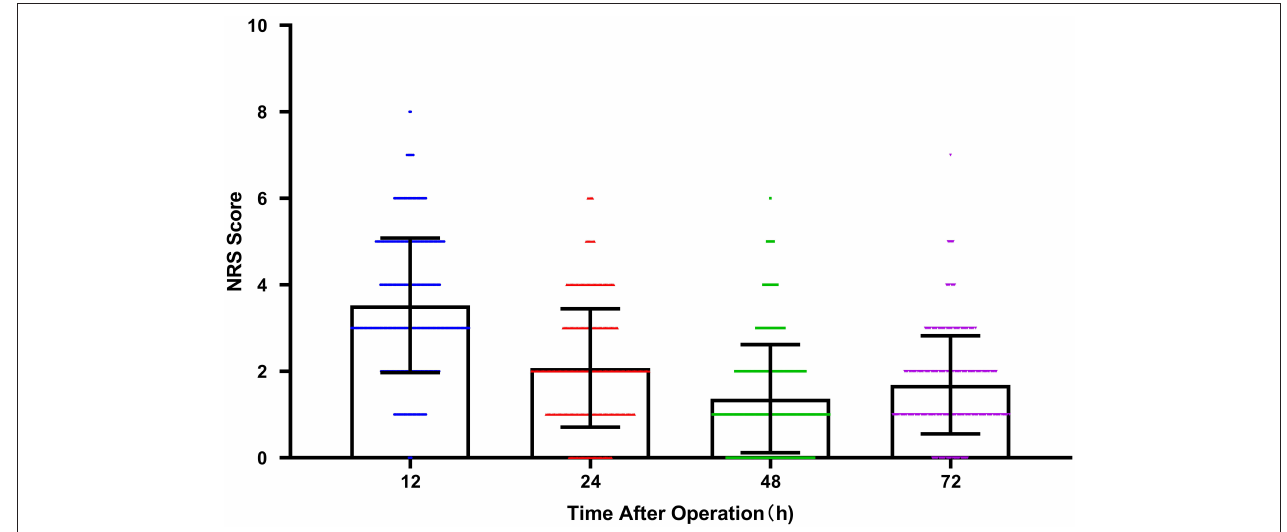
FIGURE 2 | The average pain score (NRS) with time after operation at 12, 24, 48, and 72h. Scatter plot with bar. The plot represented mean with SD. Color symbols represented individual values. (NRS, Numerical Rating